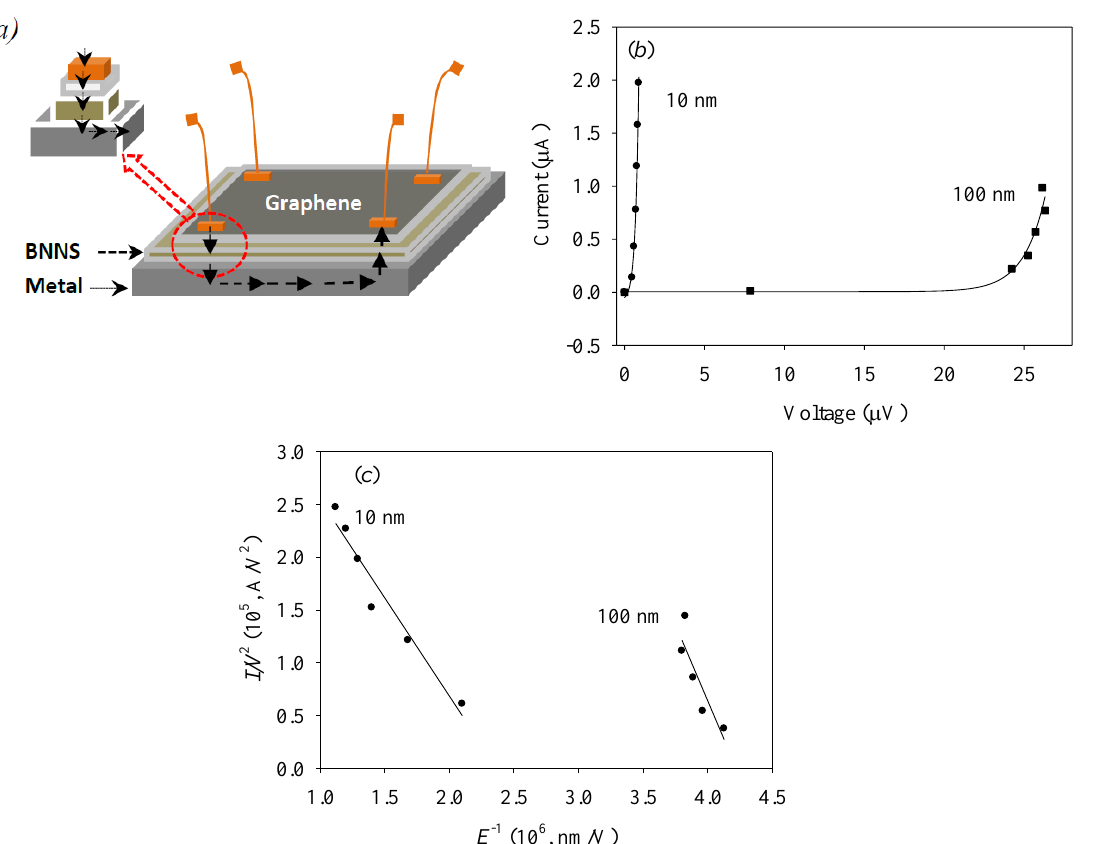
Figure 3. ( a ) Schematic illustration of G / BNNS / metal (G / BNNS / M) heterostructure tunneling device structure. ( b ) Schottky barrier characteristics measured for two G / BNNS / M devices having di ff erent BNNS thickness, curve 1 (10 nm thick BN film) and curve 2 (100 nm thick BN film). ( c ) Flower-Nordheim plot for di ff erent thickness of BNNS, circle curve shows plot for ~10 nm thickness BNNS and square plot belongs to ~100 nm thick